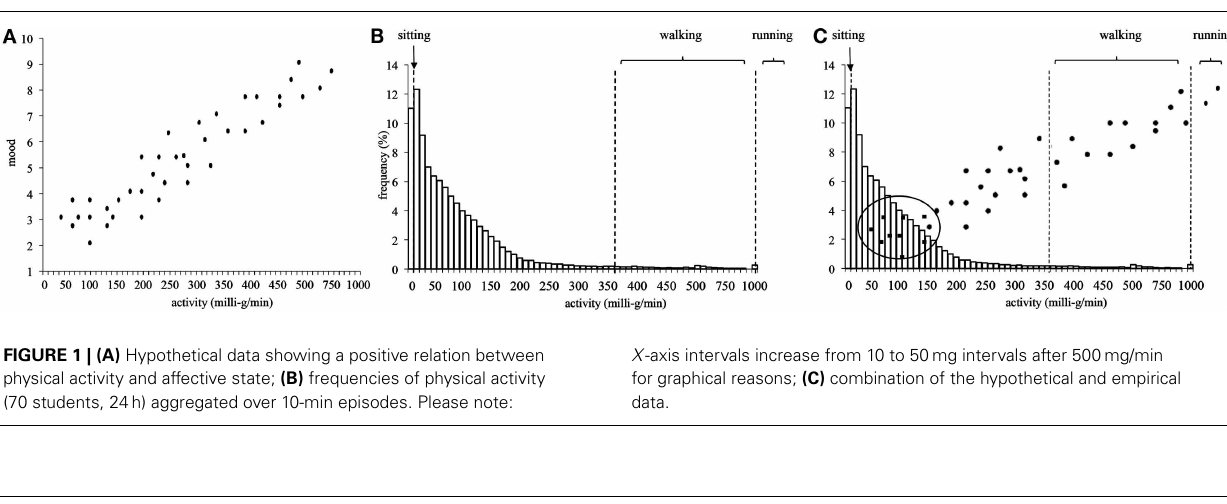
X -axis intervals increase from 10 to 50mg intervals after 500mg/min for graphical reasons; (C) combination of the hypothetical and empirical